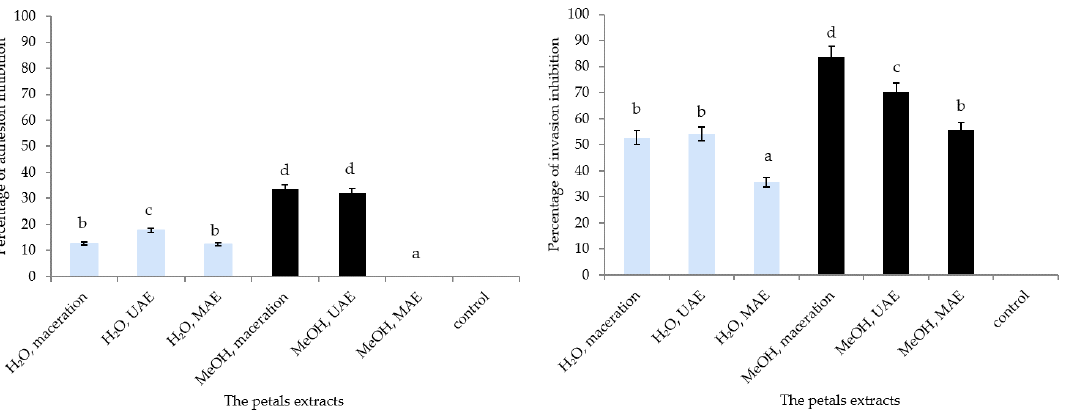
Figure 3. S. lugdunensis adhesion ( left ) and invasion ( right ) capacities to HaCaT cells treated with selected P. tenuifolia extracts; presented as percentage of adhesion and invasion compared to untreated cells (control). The letters represent statistical significance: a, p ≤ 0.05; b, p ≤ 0.001; c, p ≤ 0.0001; d, p ≤ 0.00001.